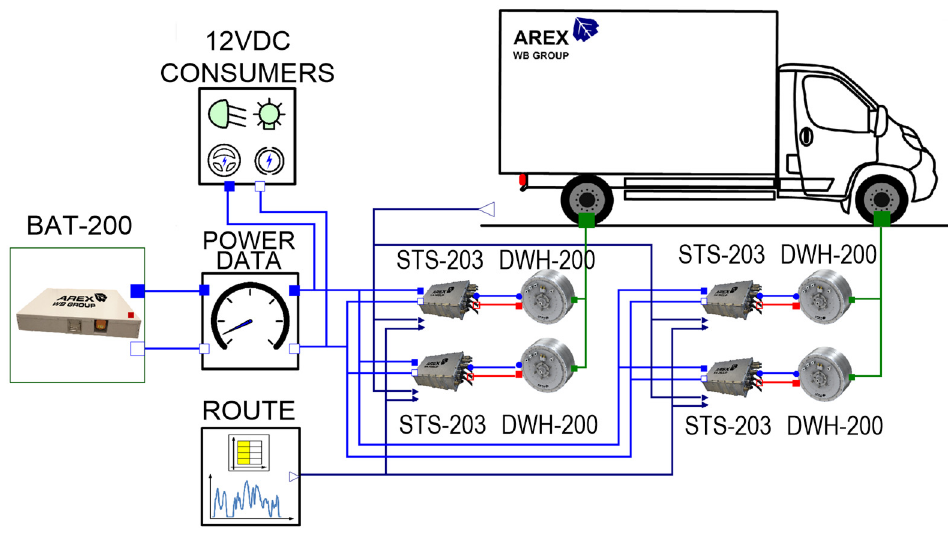
Figure 5. View and structure of the light delivery vehicle model with the drive system using electric motors located in the wheel